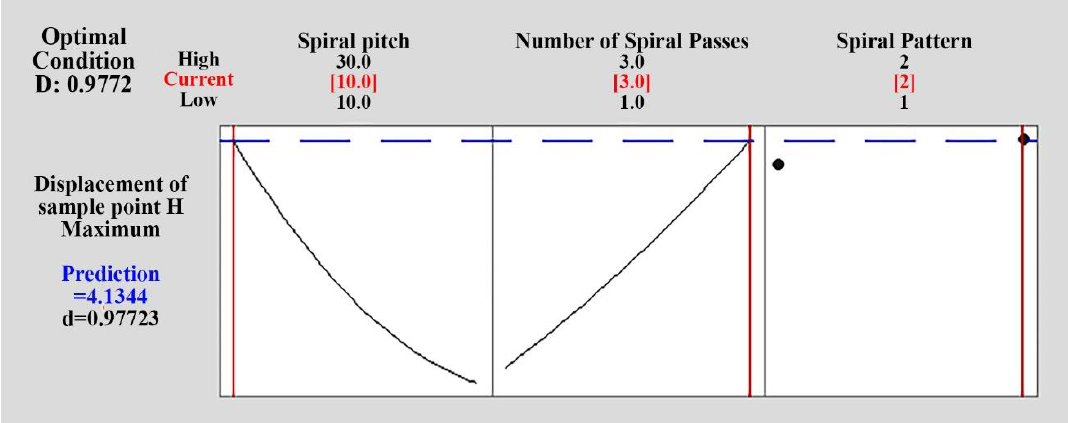
Figure 5. Parameter optimization to obtain the maximum value of displacement of sample point H.